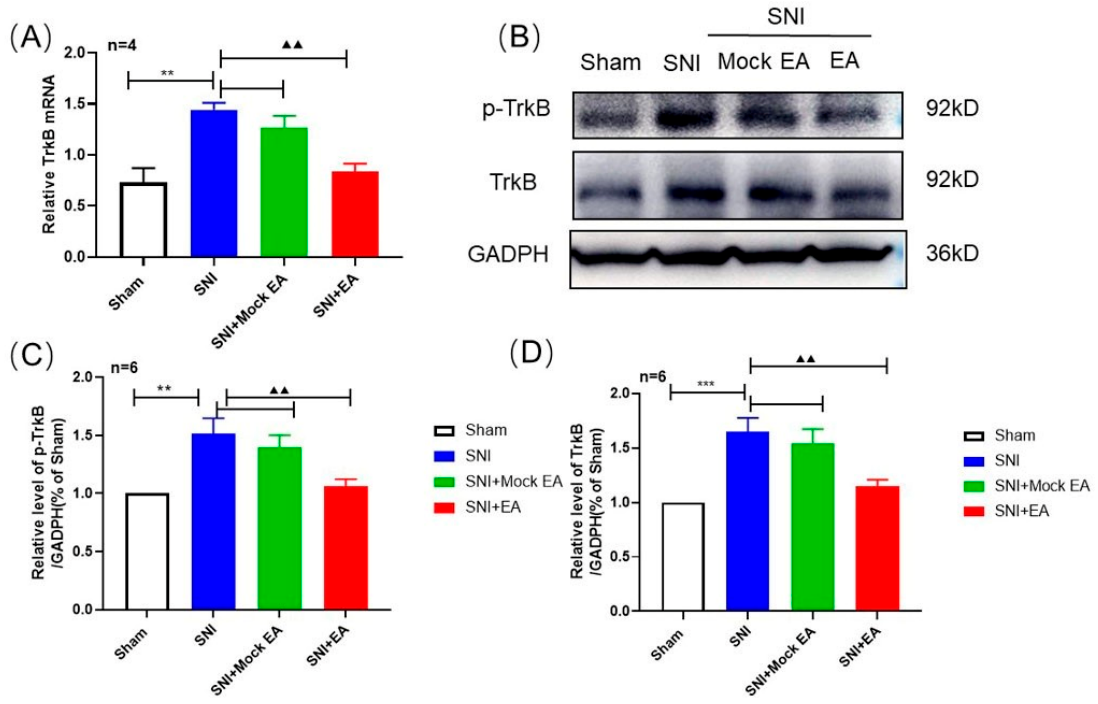
Figure 4. 2 Hz EA treatment attenuated the SNI-induced up-regulation of p-Tr κ B and Tr κ B expression in the spinal cord. ( A ) The relative level of Tr κ B mRNA expression ( n = 4 per group). ( B ) Western blotted band of p-Tr κ B and Tr κ B. ( C ) The relative level of p-Tr κ B protein expression (n = 6 per group). ( D ) The relative level of Tr κ B protein expression ( n = 6 per group). SNI increased the p-Tr κ B and Tr κ B protein expression in the spinal cord, which was inhibited by 2 Hz EA treatment. Samples were collected from spinal cord of L4-L6 segments of rats on day 14. ** p < 0.01, *** p < 0.001, compared with the sham group. ▲▲ p < 0.01, compared with the SNI group. All data were expressed as mean ± SEM, one-way ANOVA was followed by Newman–Keuls post-hoc test.